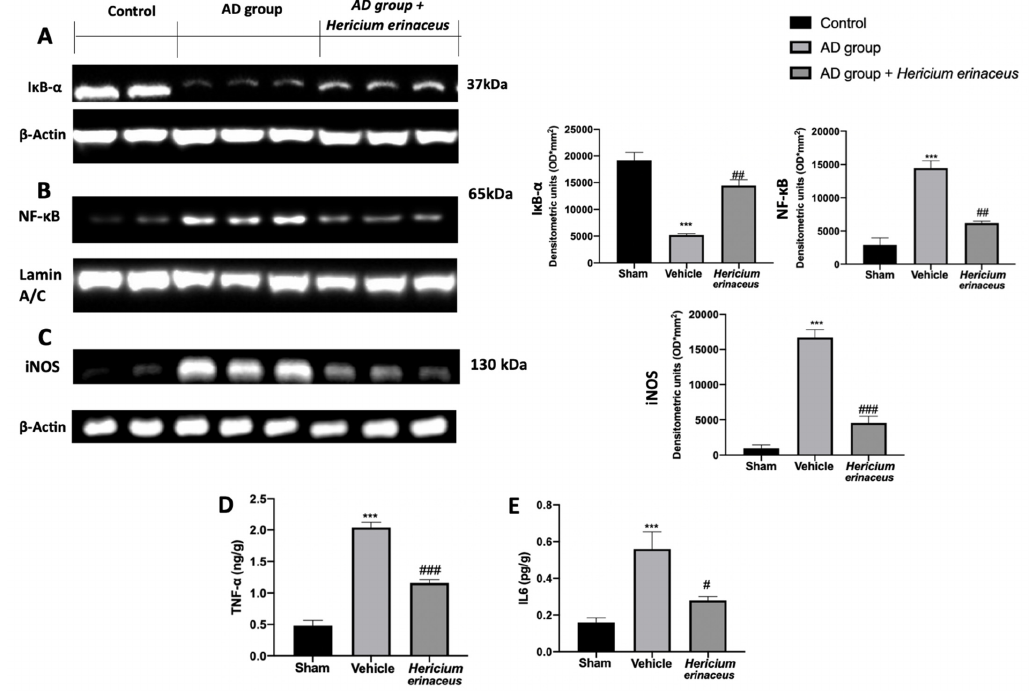
Figure 5. Hericium erinaceus administration reduced NF-kB pathway activation in hippocampus: Western blot analyses of IkB- α ( A ), NF-kB ( B ), and iNOS ( C ) expression; TNF- α ( D ) and IL6 ( E ) levels. For western blot and ELISA analyses, n = 5 animals from each group and for each analysis were employed. A p -value of less than 0.05 was considered significant. # p < 0.05 vs. vehicle, ## p < 0.01 vs. vehicle, *** p < 0.001 vs. control, ### p < 0.001 vs. vehicle.